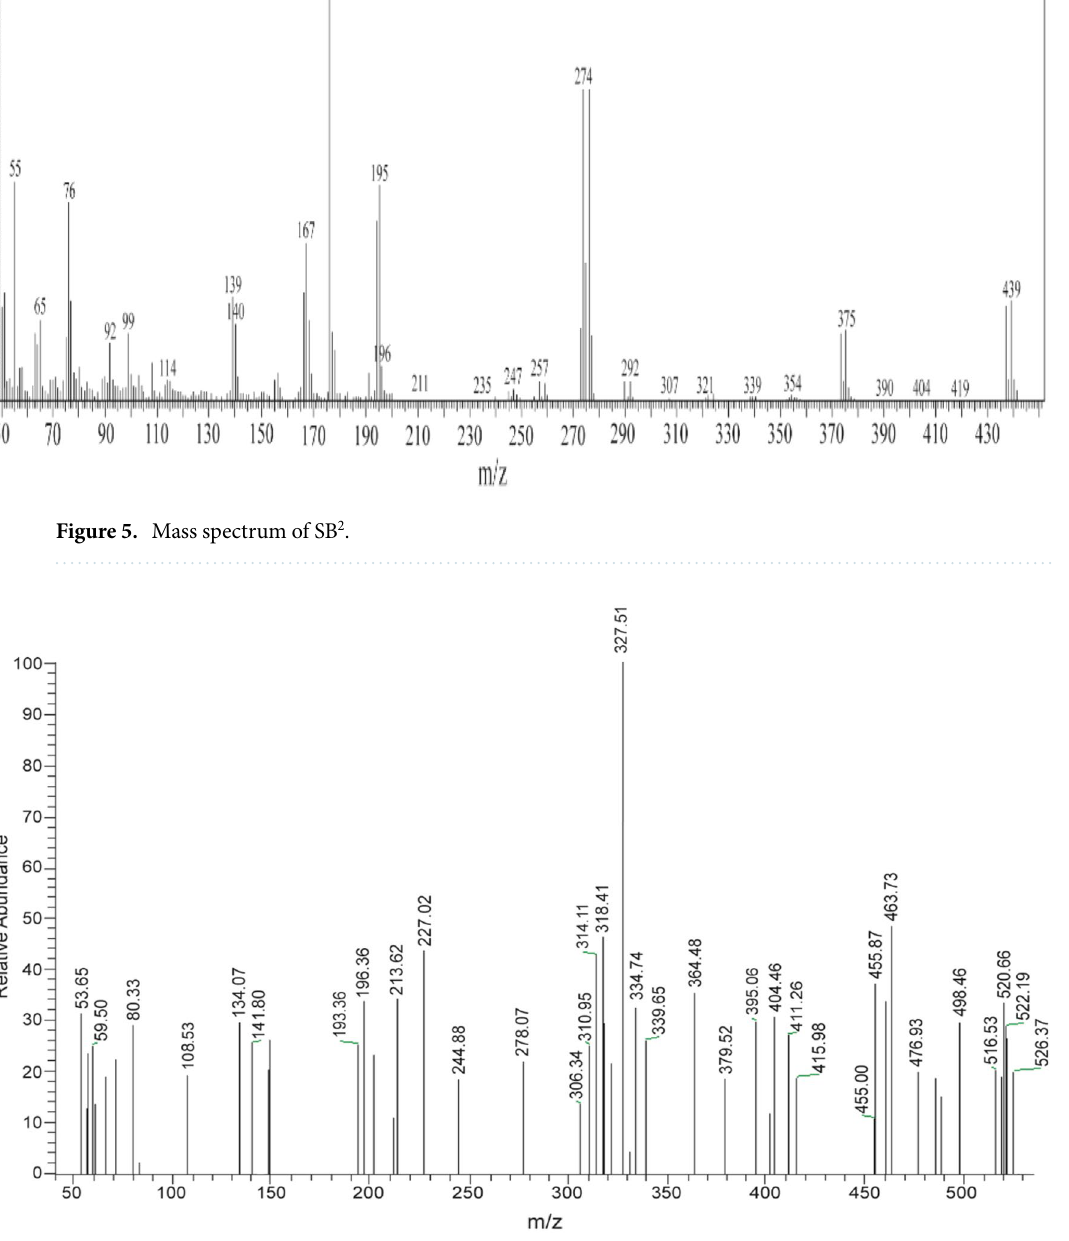
Figure 6. MS of [Ni(SB 3 –H)(OH)(H 2 O)]